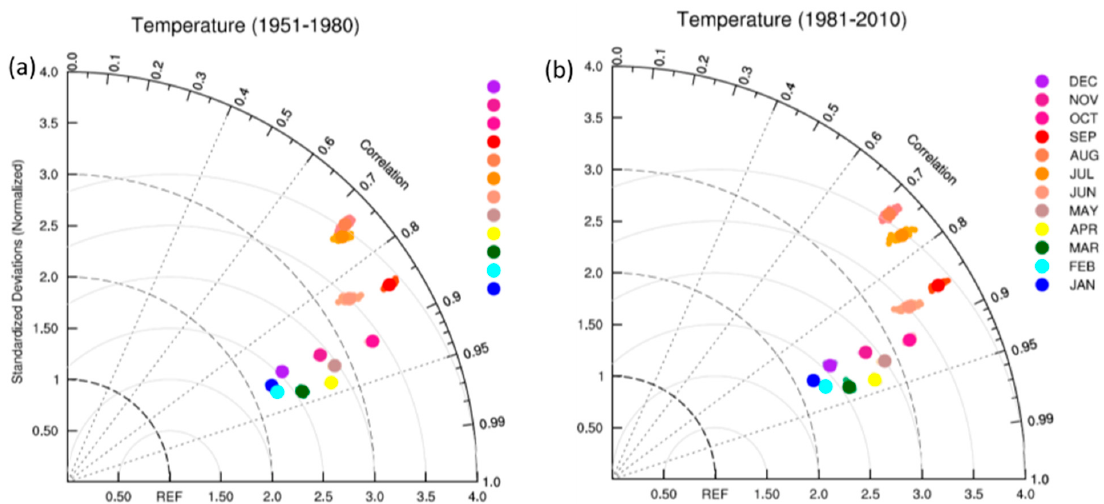
Figure 3. Taylor diagram showing correlations coefficients, standard deviations and RMSEs between AGCM simulations and IMD observation of temperature for the two climate periods ( a ) 1951–1980 and ( b ) 1981–2010. Dark color marks correspond to the results for ensemble mean and light color marks correspond to each individual member.